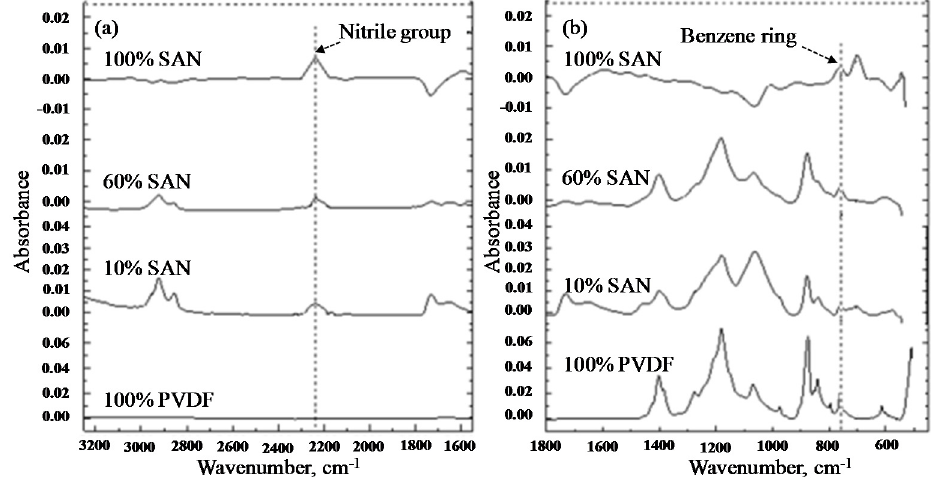
Figure 6. Fourier transform infrared (FTIR) ‐ attenuated total reflectance (ATR) spectra of ( a ) styrene ‐ acrylonitrile; ( b ) SAN: styrene ‐ acrylonitrile blended PVDF membranes.